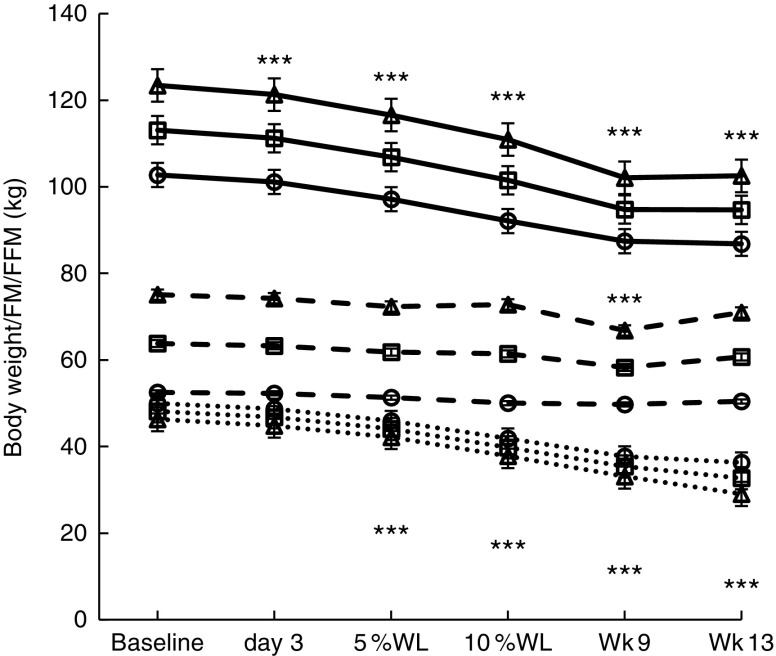
Body weight and composition over time in all participants, men and women, with progressive weight loss. Values are estimated marginal means with their standard errors. Wk9, week 9; Wk13, week 13; WL, weight loss; FM, fat mass; FFM, fat-free mass; □, all participants; ∆, males; ○, females; , body weight; , FFM; , FM. Significant differences from baseline in all participants: ***P<0·001 for body weight, FFM and FM.